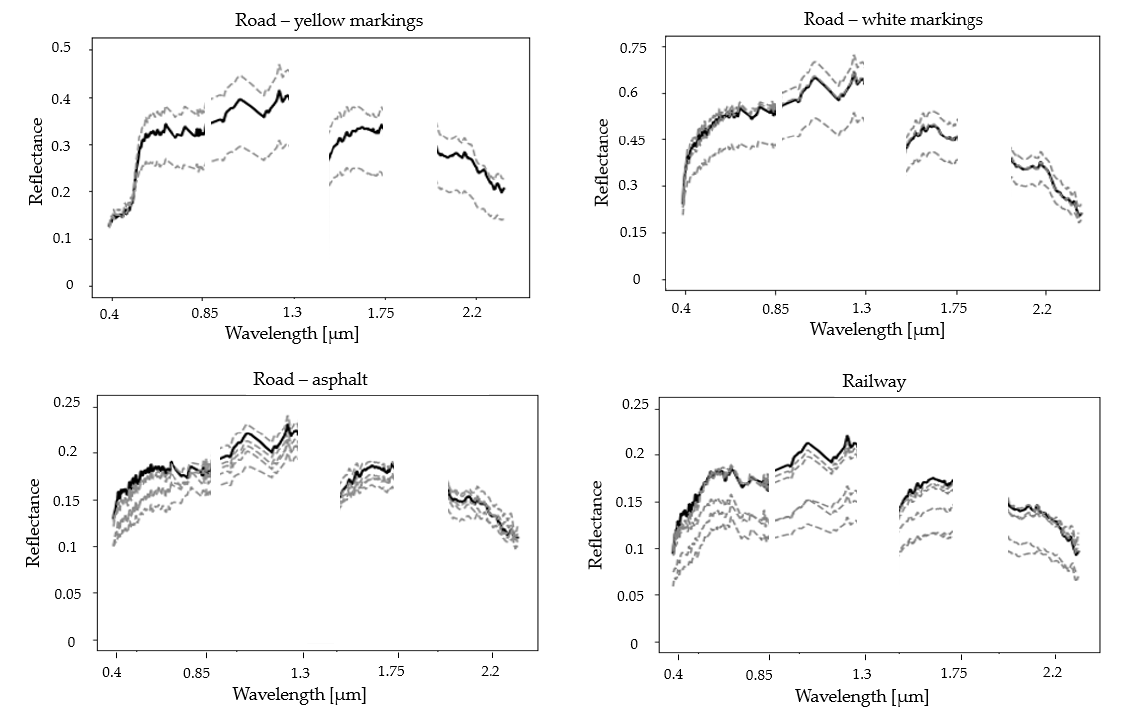
Figure 9. Spectral library of low and high vegetation, building (red, brown, and black roof tiles), road (yellow and white markings and asphalt), and railway generated after alignment after the II segmentation iteration. The bold black line in each plot represents the average image spectrum of each class.